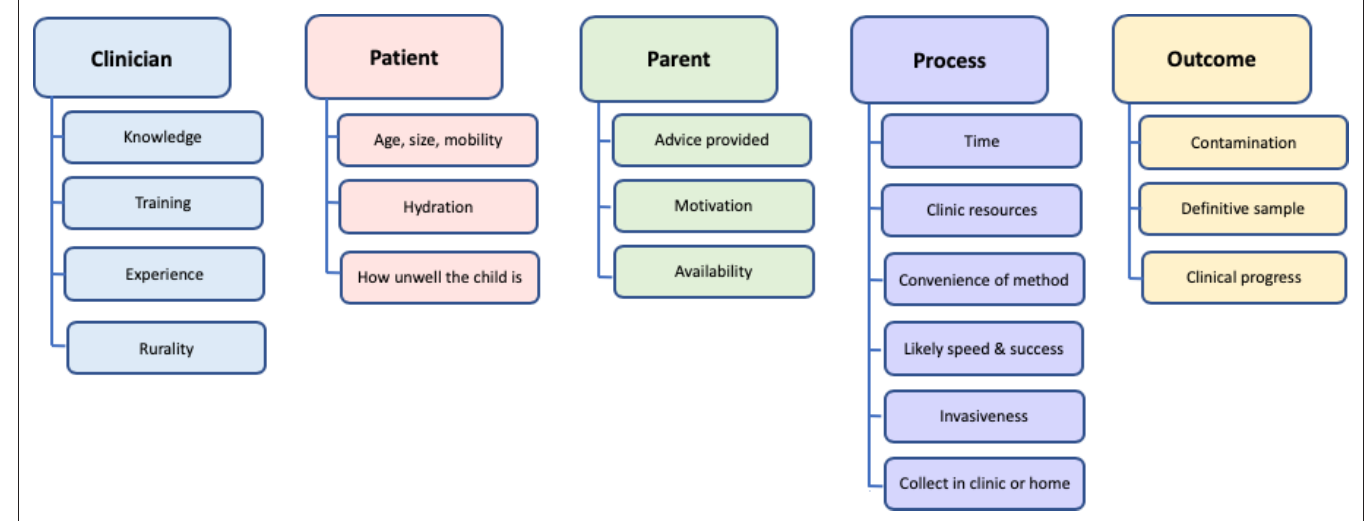
Figure 1 Barriers and enablers to urine sample collection from young children: themes and subthemes